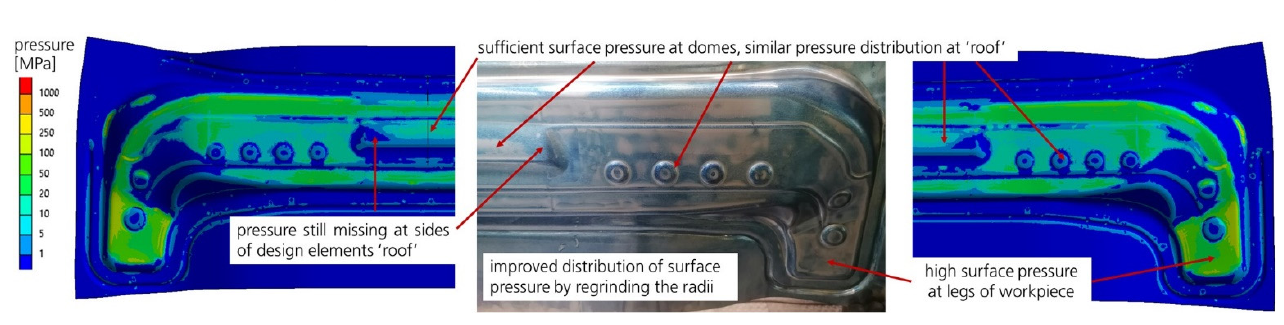
Figure 12. Spotting patterns with 6 MN press force after mechanical processing of the radii.